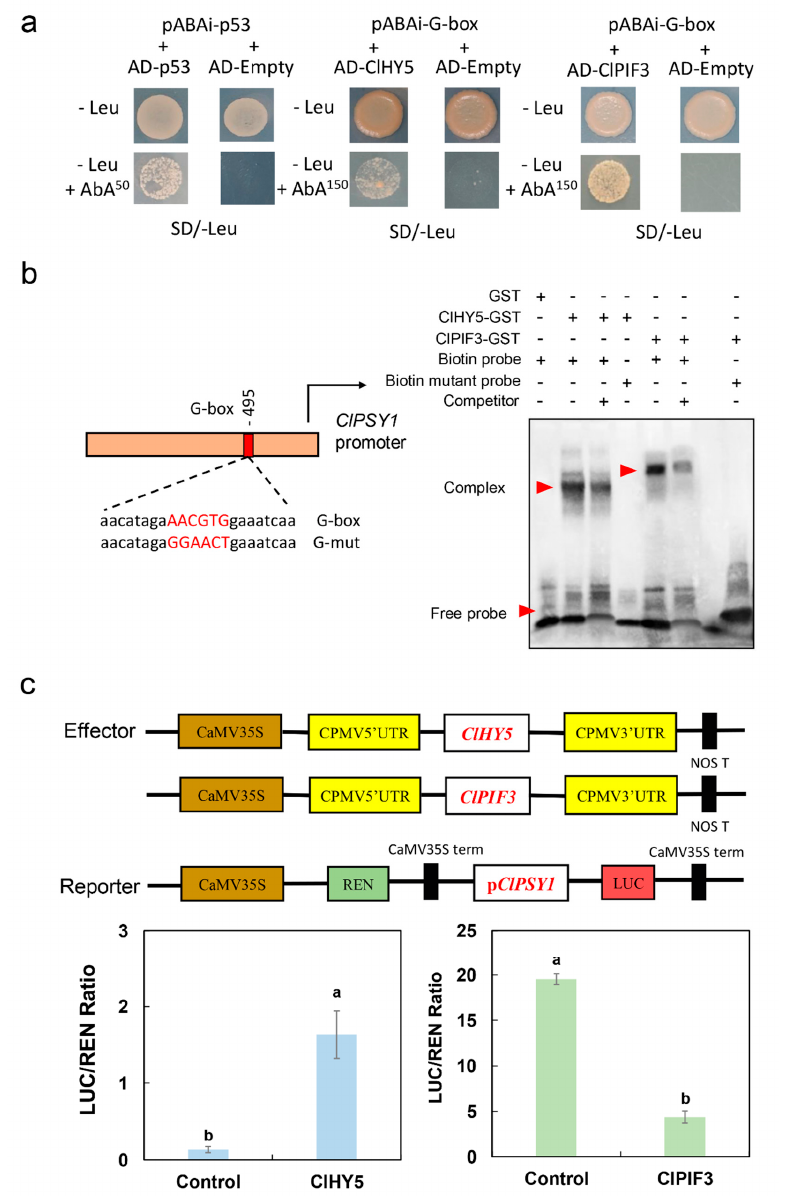
Figure 5. ClHY5 as a positive regulator and ClPIF3 as a negative regulator to regulate ClPSY1 expression via binding promoter G-box cis -element. ( a ) Yeast one-hybrid (Y1H) assay showing that ClHY5 and ClPIF3 were bound to the G-box element of the ClPSY1 promoter. The empty pGADT7-p53 and pAbAi-p53 vectors were used as the positive control, while the empty pGADT7 and pAbAi-G-box were used as the negative control. ( b ) Direct